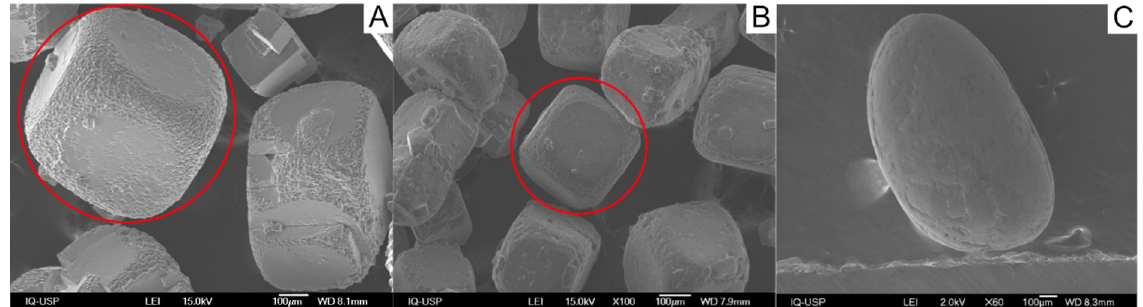
Figure 2. Sample SEM images of typical morphologies of crystals of ( A ) NaCl, ( B ) KCl, and ( C ) Na 2 SO 4 from the commercial reagents.